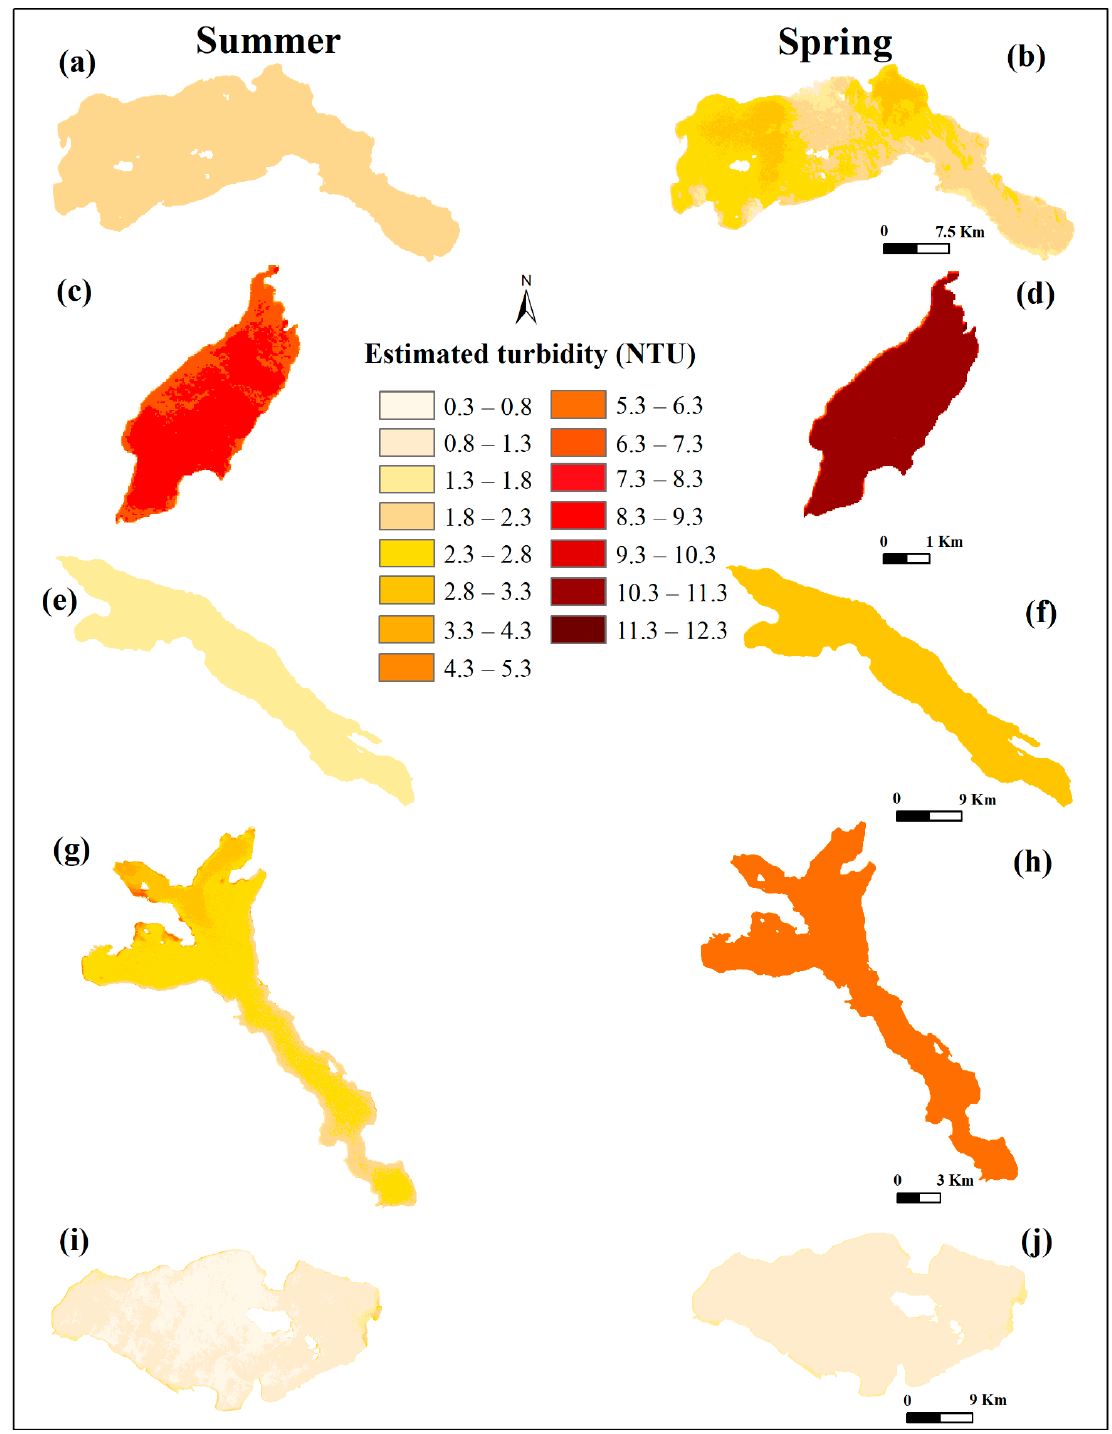
Figure 5. Spatial distribution of estimated turbidity in summer and spring season during the 2015 year for ( a , b ) Calafquén lake, ( c , d ) Neltume lake, Riñihue lake, ( e , f ), Panguipulli lake ( g , h ), and ( i , j ) Puyehue lake.